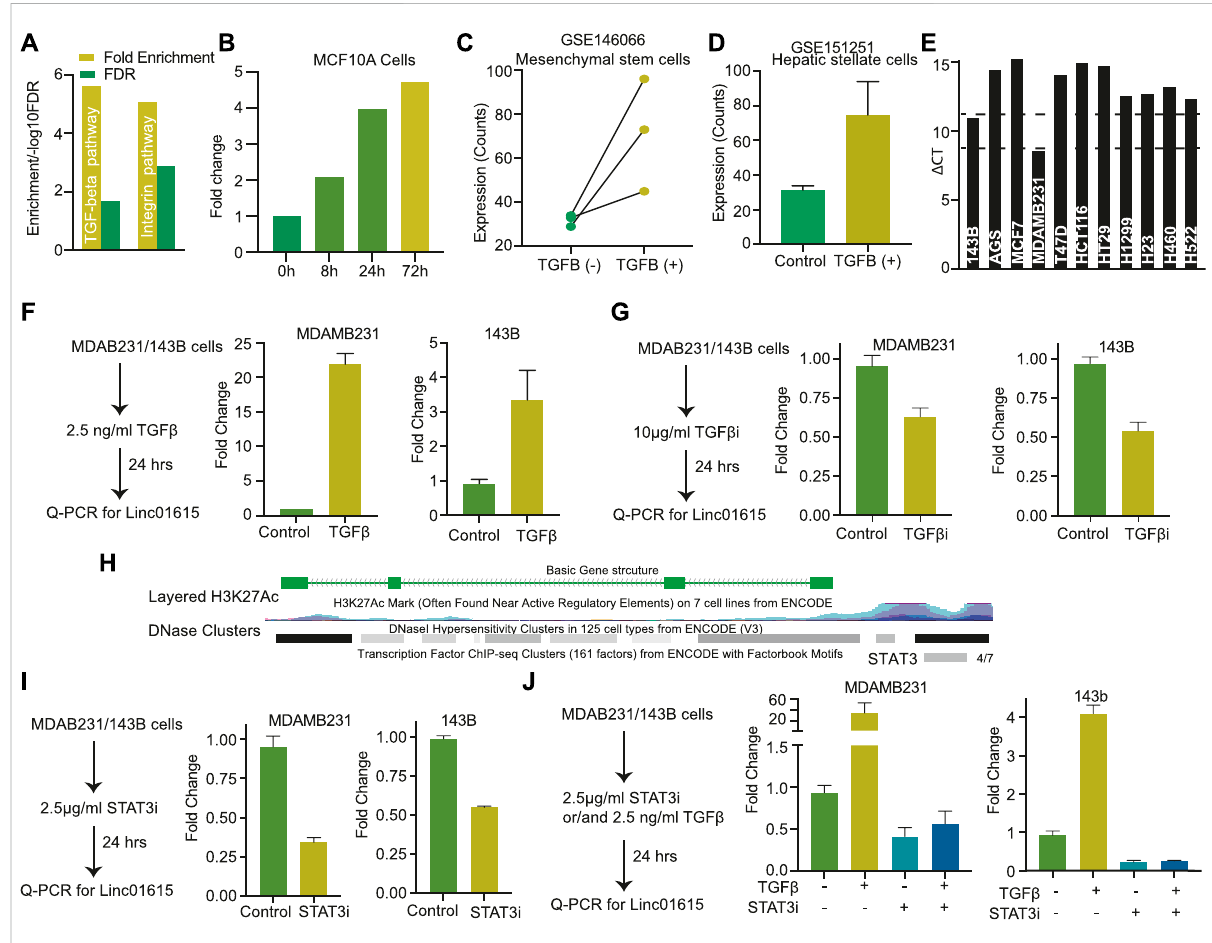
Linc01615 is regulated by the TGF β pathway: (A) The genes with a high correlation coef fi cient with Linc01615 expression were used for KEGG pathway analysis. The Fold enrichment and FDR of enriched pathways are depicted. (B) Expression level of Linc001615 in MCF710A cells after treatment with TGF β at mentioned time points. Expression of Linc01615 after TGF β treatment in (C) mesenchymal stem cells and (D) hepatic Stellate cells. (E) Expression of Linc01615 in different cells as identi fi ed using semi-quantitative PCR. (F) Expression of Linc01615 RNA after TGF β treatment in MDAMB231 and 143B cells. (G) Expression of Linc01615 RNA after TGF β inhibitor in MDAMB231 and 143B cells. (H) UCSC genome browser image showing the binding site of STAT3 on the promoter of Linc01615. (I) Expression of linc01615 RNA after STAT3 inhibitor treatment